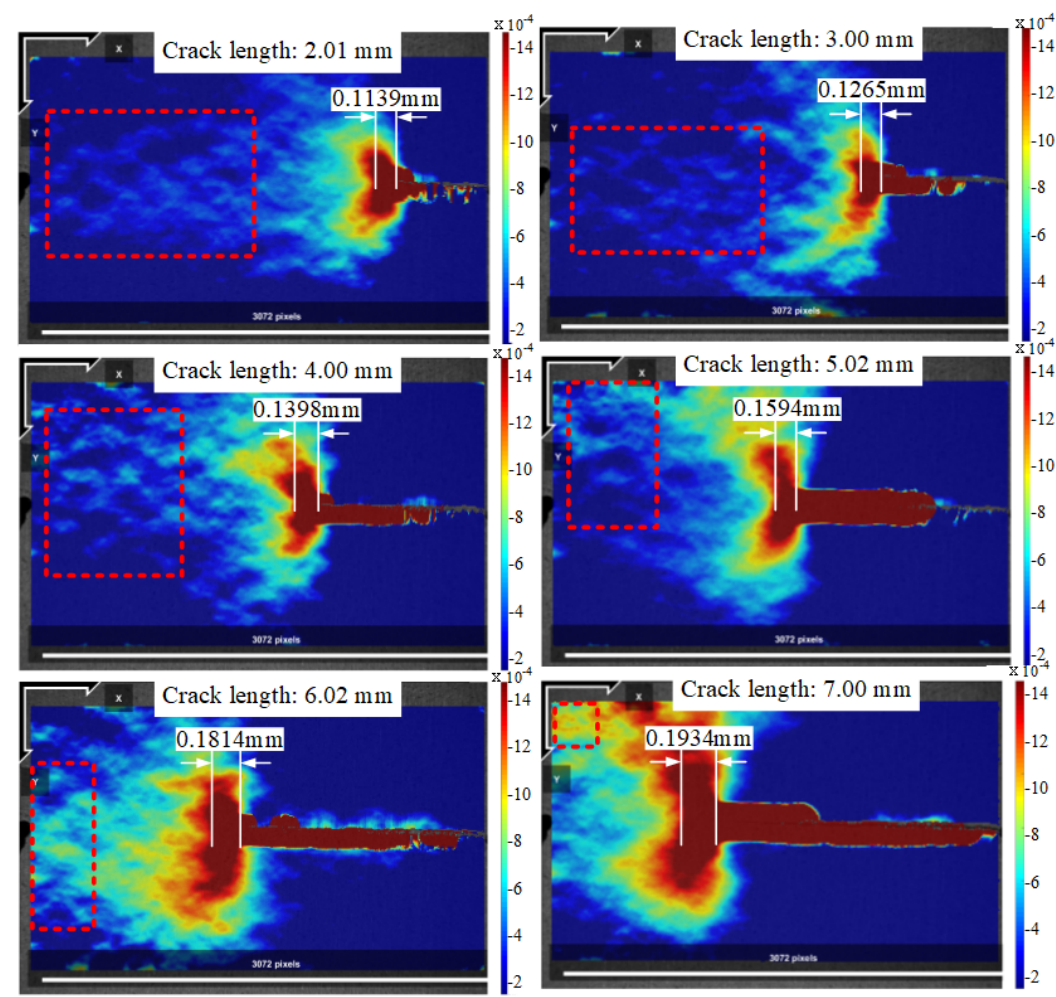
Figure 6. The measurement results of the PZ size ahead of the crack tip with crack propagation based on the DIC method.